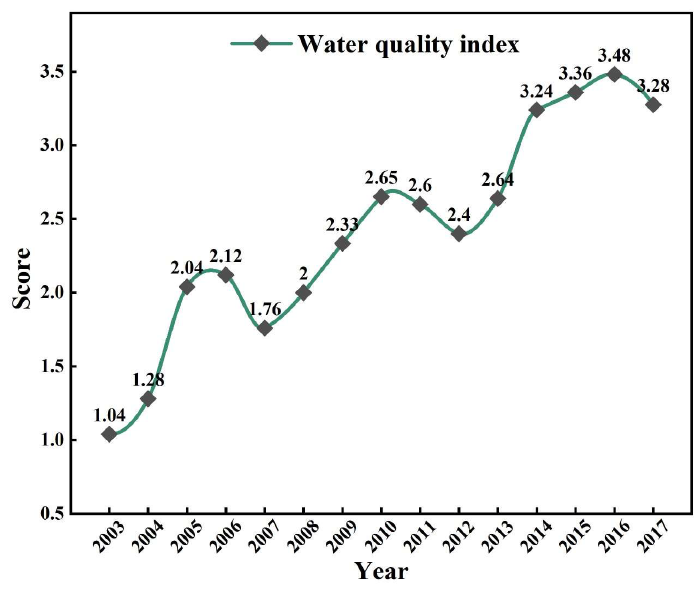
Figure 3. Changes of water quality in Chengde from 2003 to 2017.